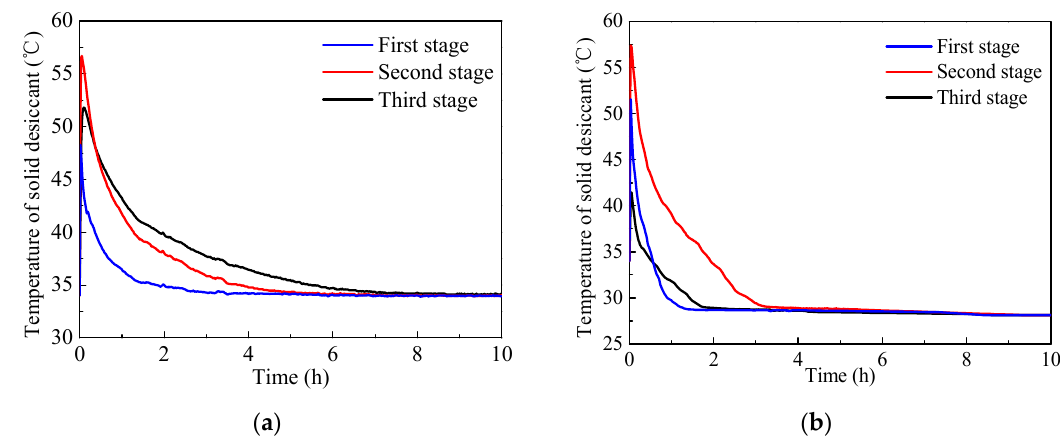
Figure 14. Variation of the average temperature of solid desiccant of each stage: ( a ) without internal cooling; ( b ) with internal cooling.